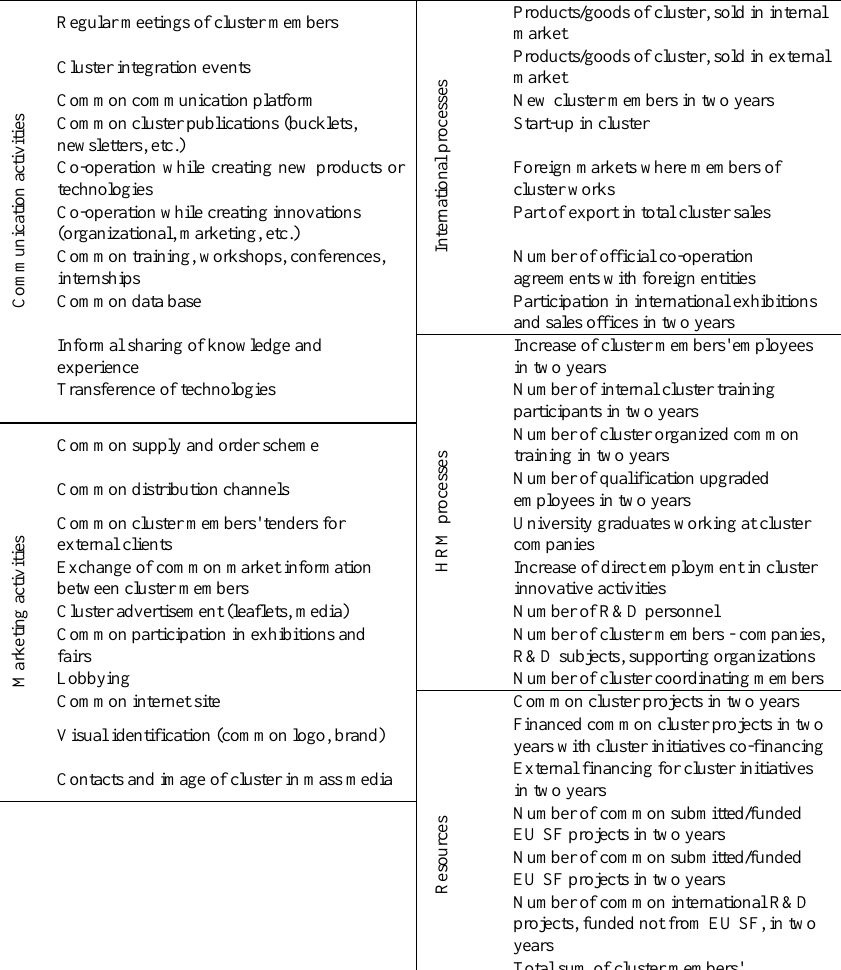
Table 1. Indicators of clusters’